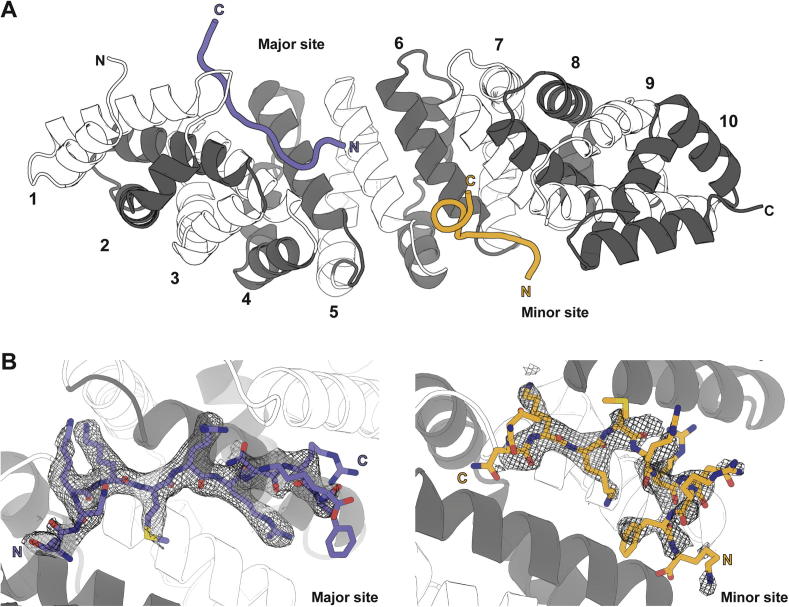
(A) Overview of the 2.4 Å crystal structure of the ΔIBB mouse Importin-α1:HNF1βNLS complex. Two copies of the NLS peptide were observed where one was bound in the major site (blue) and another in the minor site (yellow). Each ARM repeat of mouse Importin-α1 has been labelled with alternating colours. (B) Final 2Fo-Fc electron density map around NLS peptide in major and minor binding sites on mouse Importin-α1 contoured at 1σ.